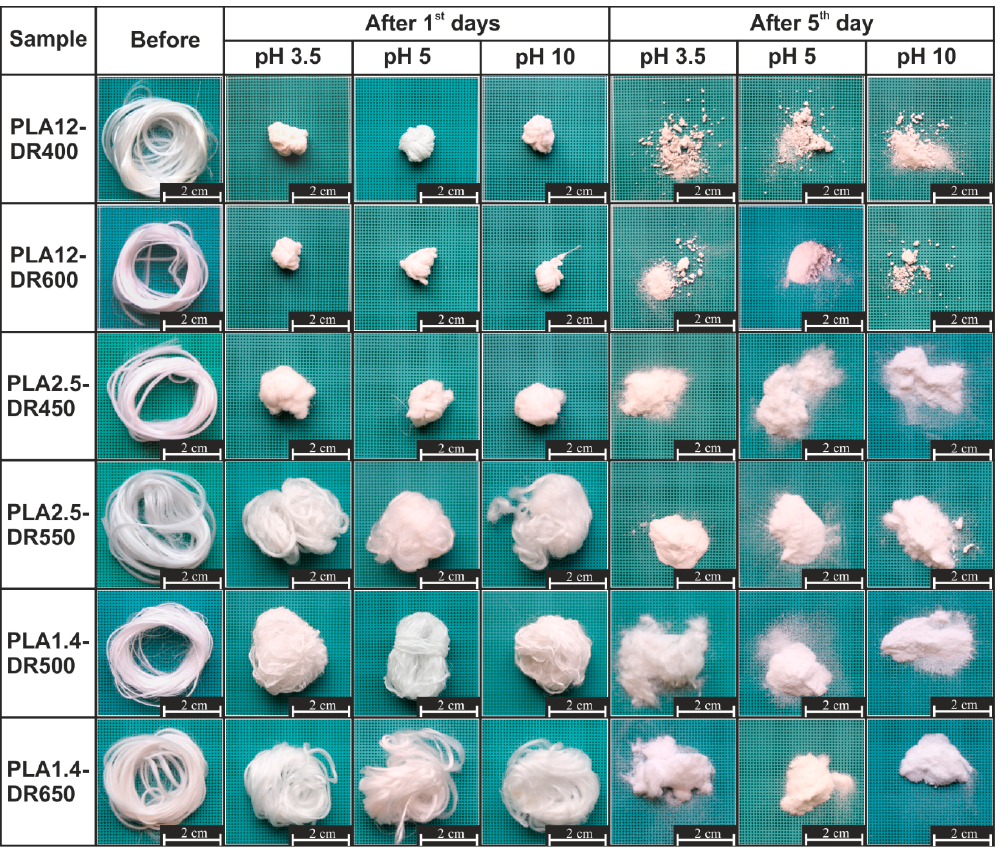
Figure 1. Photographic documentation of the thermal-supported hydrolytic degradation of fibres obtained from PLA. obtained from